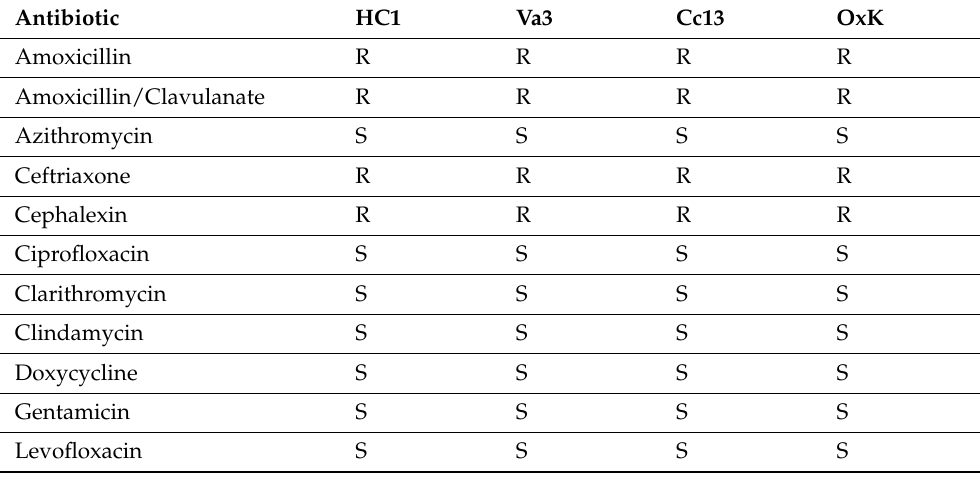
Table 2. Antibiotic sensitivity of O. formigenese strains (R = resistant; S =